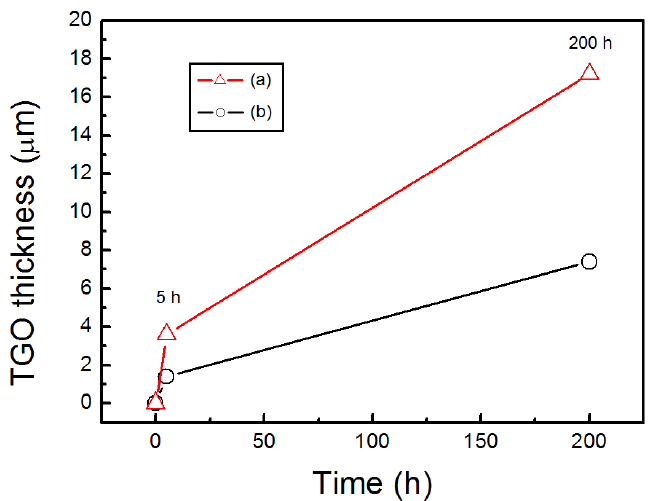
Figure 8. TGO thickness as a function of oxidation time for (a) as sprayed sample, and (b) Al coated